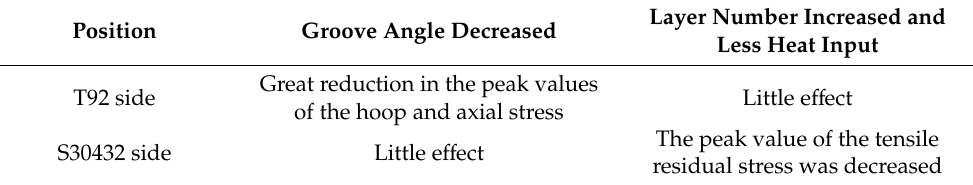
Table 8. Results from